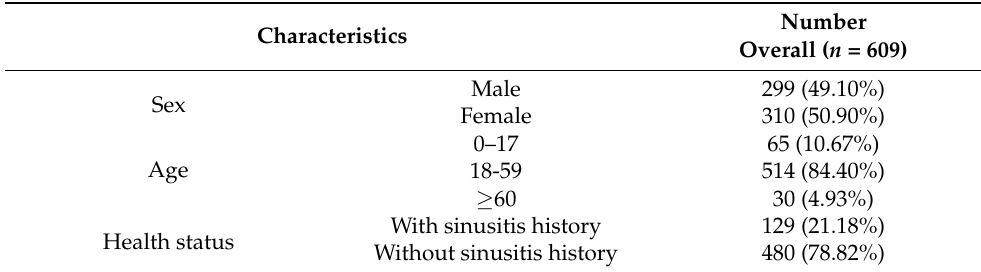
Table 1. Characteristics of 609 participants in the